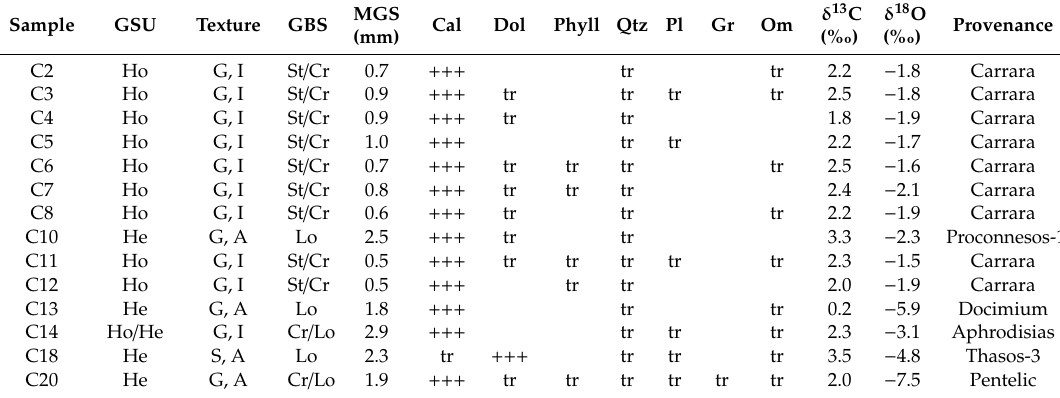
Table 2. Main mineralogical and petrographic features, carbon–oxygen isotopic data and the most probable provenance of the marble samples coming from the city of